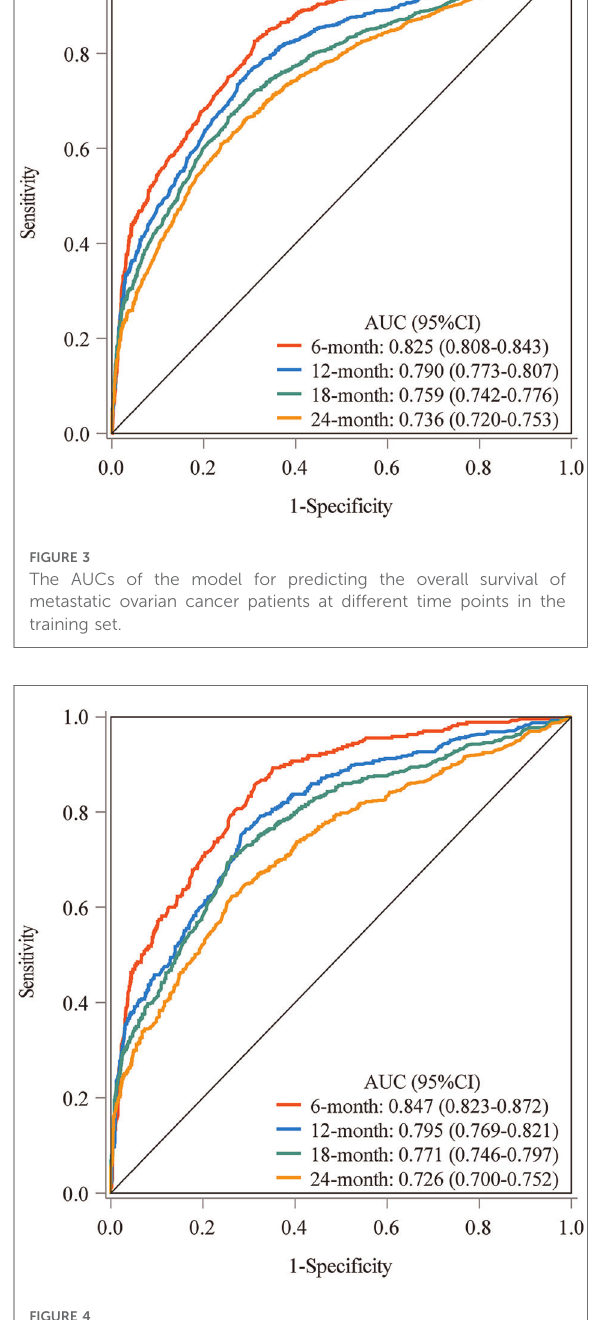
FIGURE 4 The AUCs of the model for predicting the overall survival of metastatic ovarian cancer patients at different time points in the testing